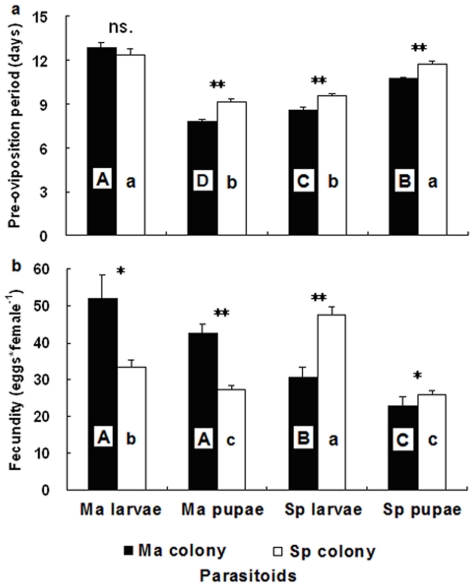
The performance of Sclerodermus harmandi females from different culturing systems on two host species and stages: (2a) pre-oviposition period of adult females, (2b) female fecundity. Same alphabets on columns indicate no significant differences (P<0.05).For abbreviations see Figure 1 (Mean±SE, n = 20–24 females in each treatment, ** P<0.01, * P<0.05 and ns. P>0.05).